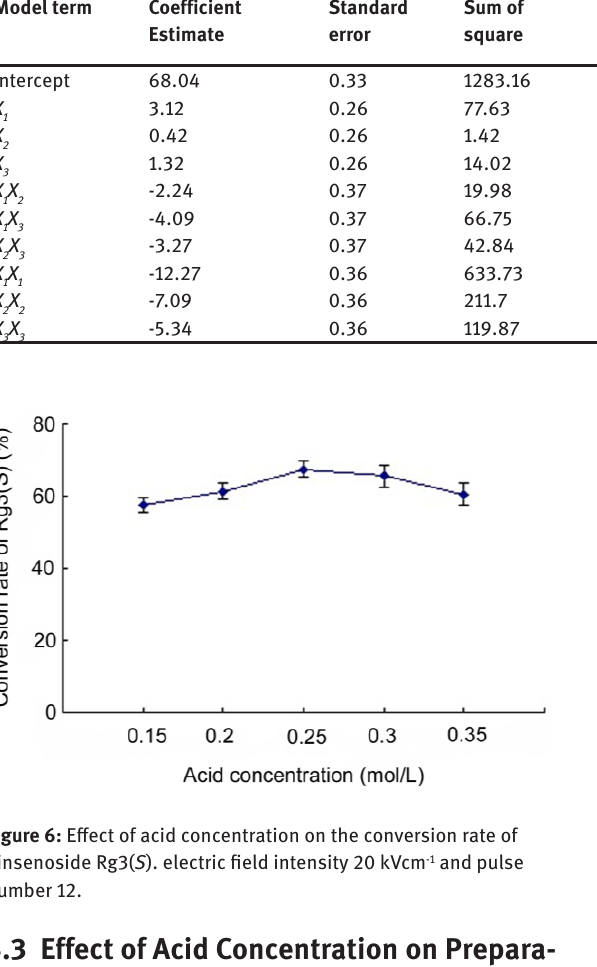
Table 3: Regression coefficients estimate significance test for the quadratic polynomial model. Model